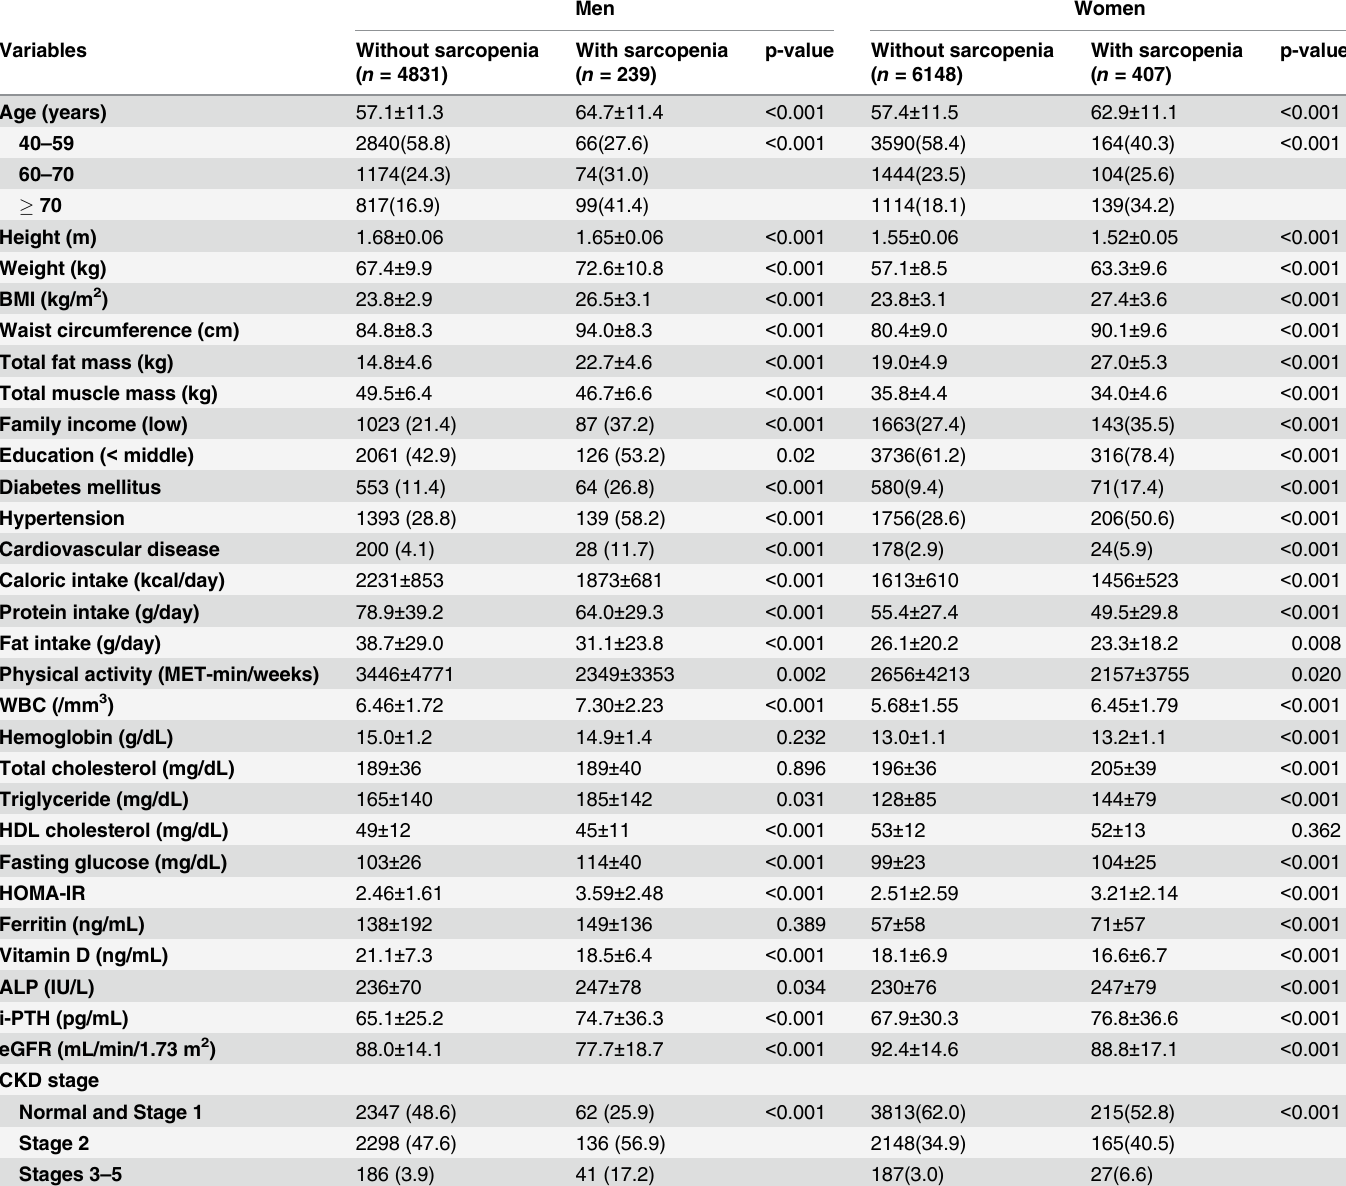
Table 1. Clinical characteristics of Koreans aged 40 years or older according to sarcopenia status.